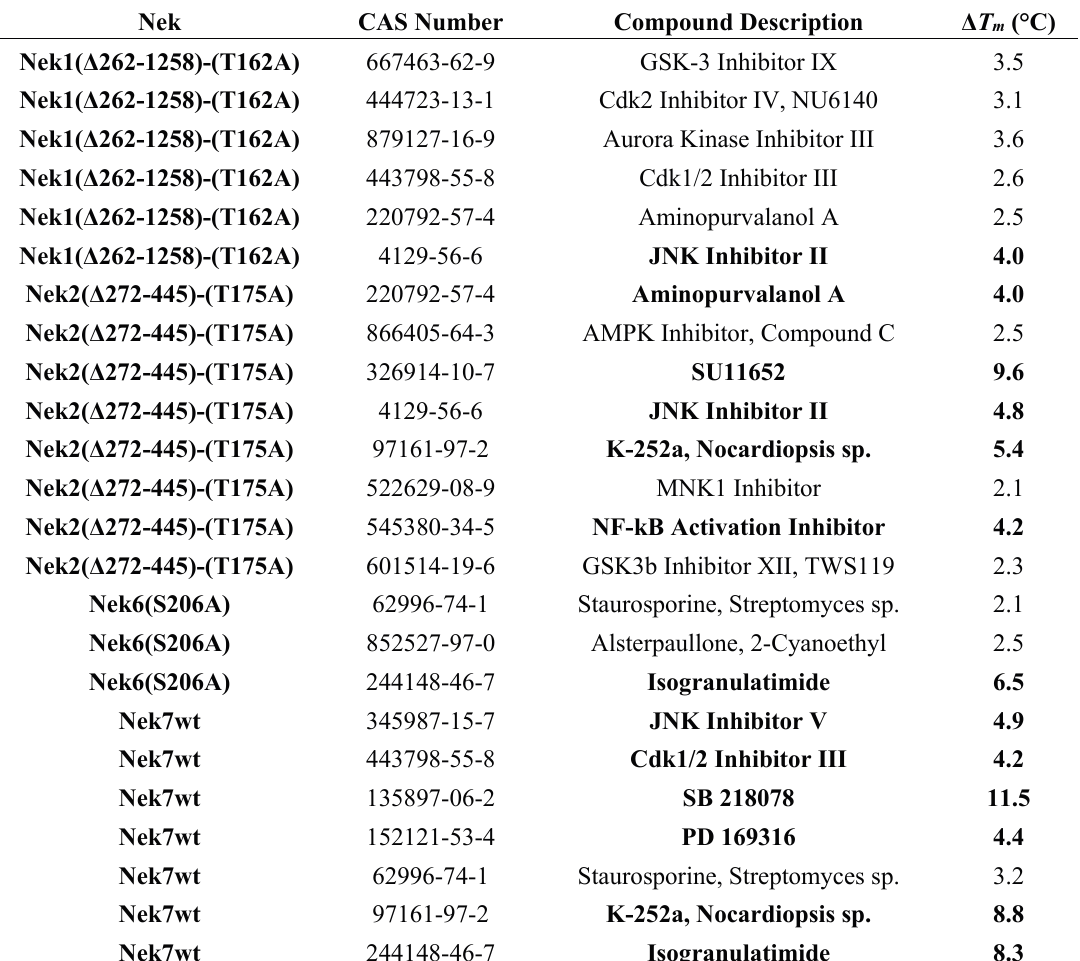
Table 1. Summary of recombinant hNeks 1, 2, 6 and 7 thermal shift inhibitor screen showing only compounds with Δ T m ≥ 2 °C. Names of compounds showing a significant thermal shift ( Δ T m ≥ 4 °C) are depicted in